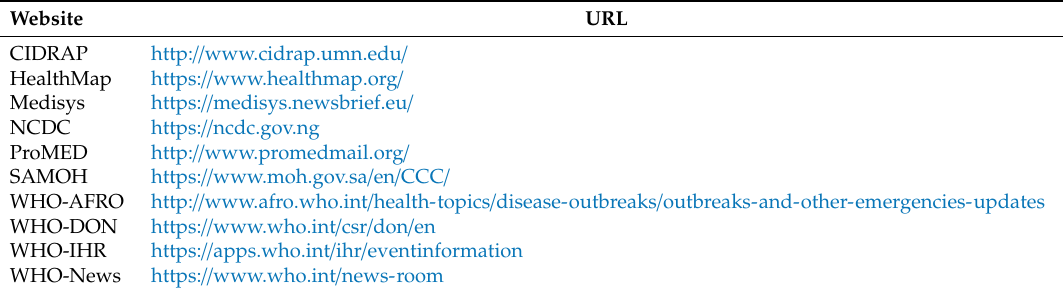
Table 1. List of websites for data